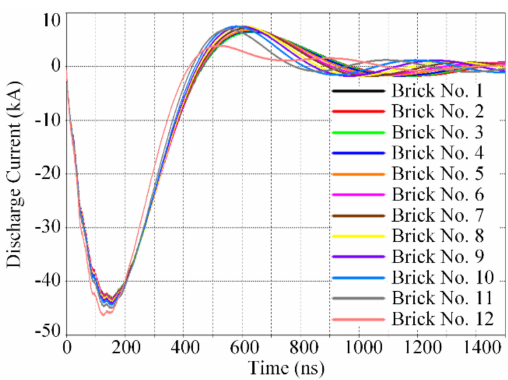
Figure 20. Simulated current waveforms of main discharging bricks of the single-stage